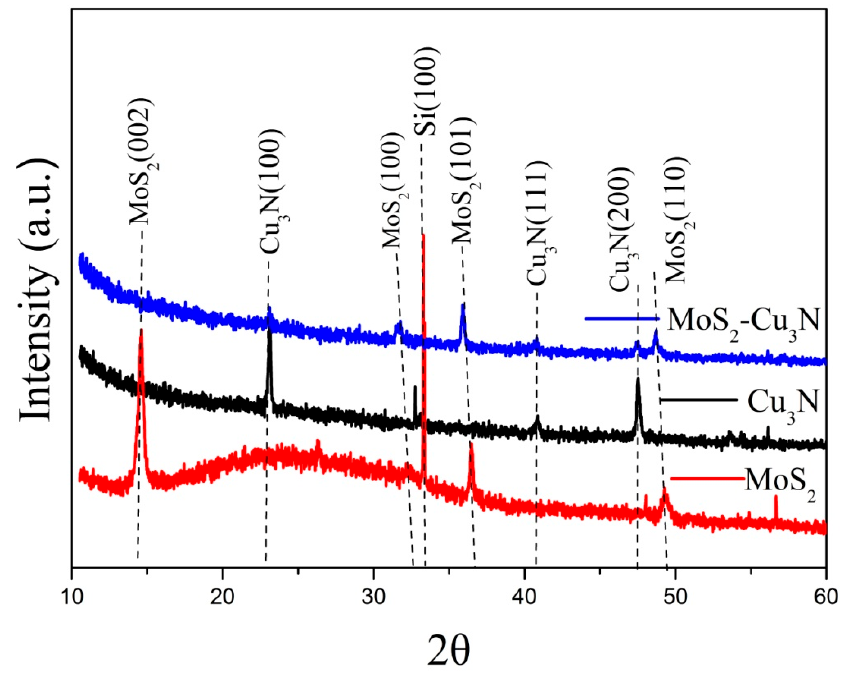
Figure 1. XRD patterns of the MoS 2 layer, Cu 3 N layer, and Cu 3 N/MoS 2 heterojunction.